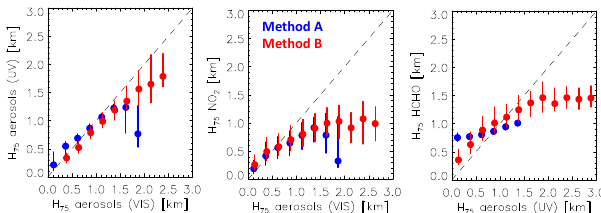
Figure 16. Three binned scatter plots: aerosol profile heights re- trieved in the Vis, vs. profile heights retrieved in the UV (left), aerosol profile height retrieved in the Vis vs. NO 2 profile heights (middle), aerosol profile heights retrieved in the UV vs. HCHO pro- file heights (right). Note that models A and B have very different frequency distributions of characteristic profile heights for the three constituents, see Fig.